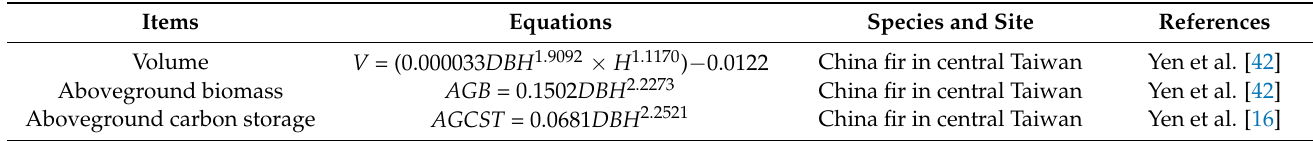
Table 1. The volume, aboveground biomass, and aboveground carbon storage equations used in this study. Items